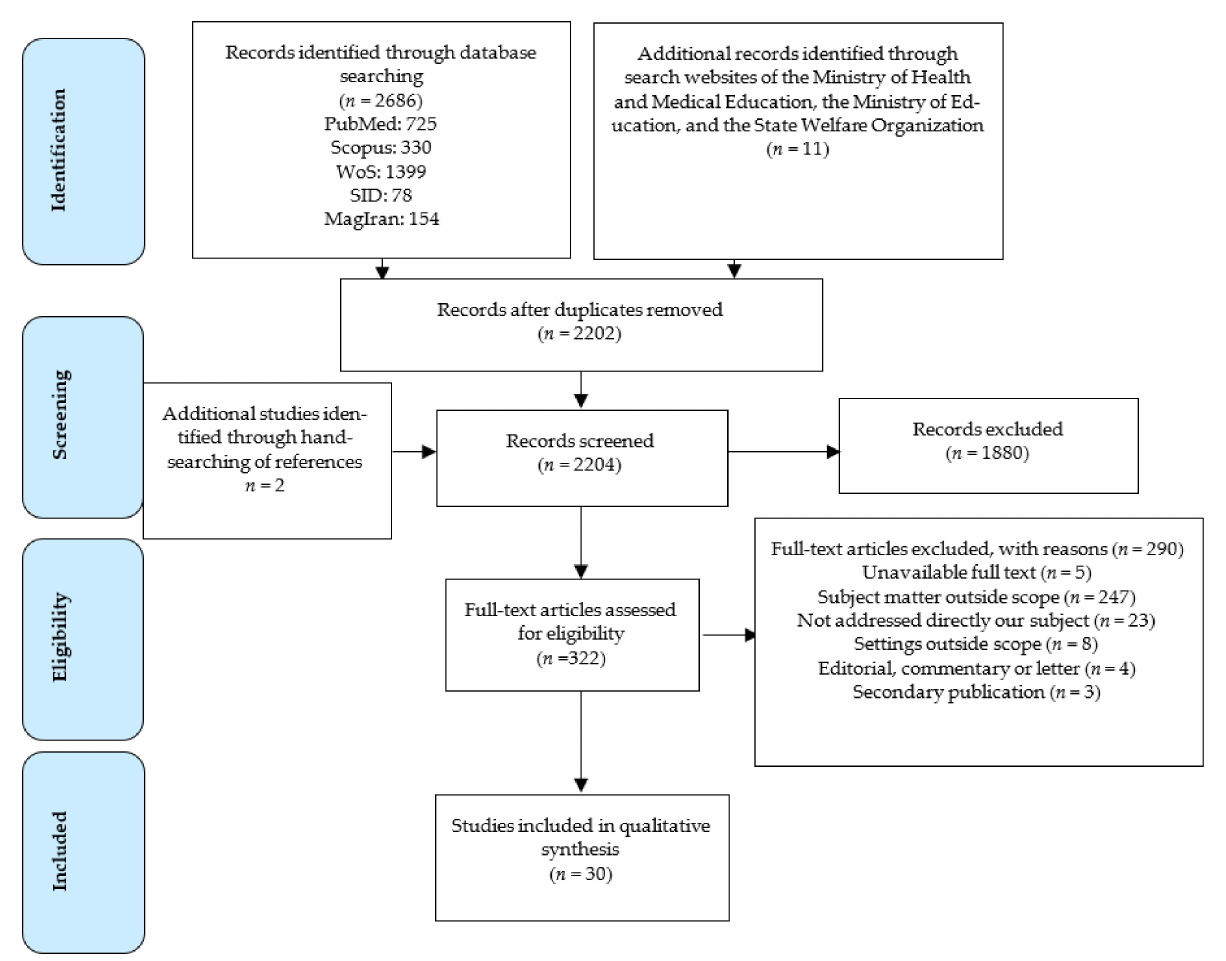
Figure 2. Flow diagram for the study selection